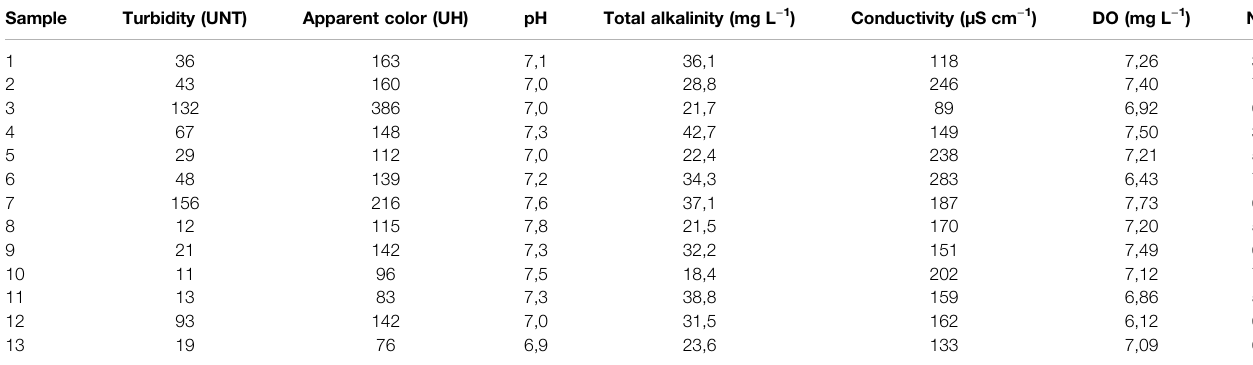
TABLE 4 | Physicochemical quality parameters of Tibagi River water samples. Sample Turbidity